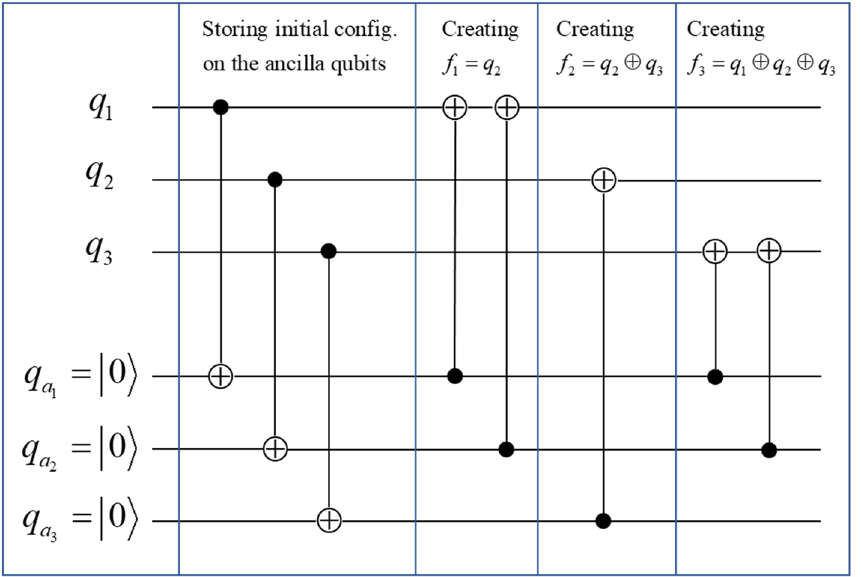
Figure 4. A 3-qubit example of systematically creating any functional configuration by first storing the initial configuration on 3 ancilla qubits and then creating the functionals one by one without changing the ancilla